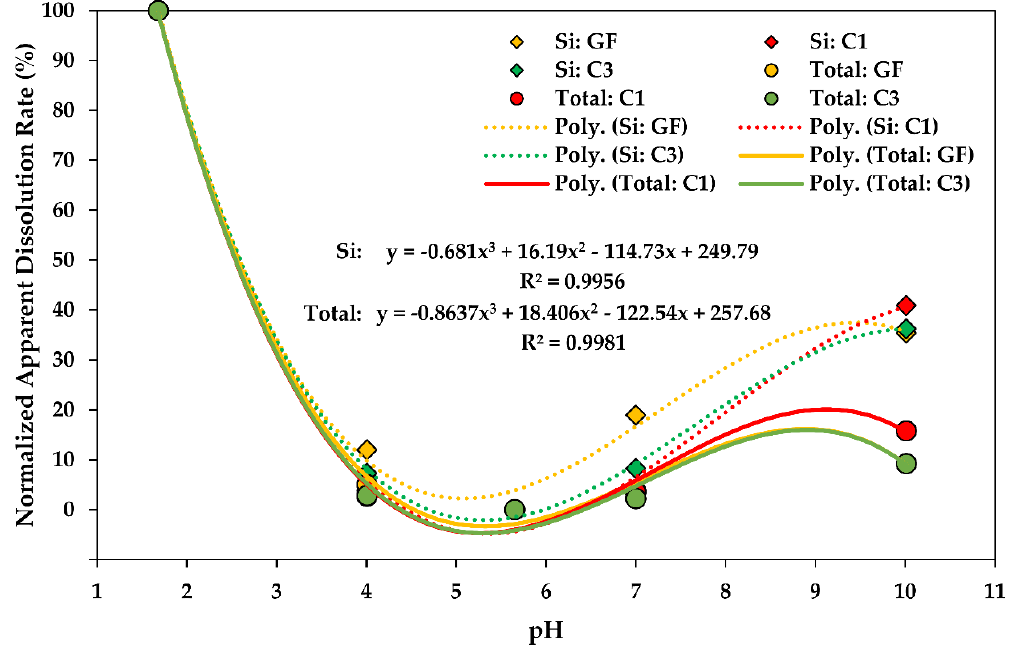
Figure 12. Normalized activation energy of the steady-state glass dissolution as a function of pH for R-GFs [16] and R-GFRPs (legend: C1 and C3 stand for hoop and transverse R-GFRP plates, respectively).